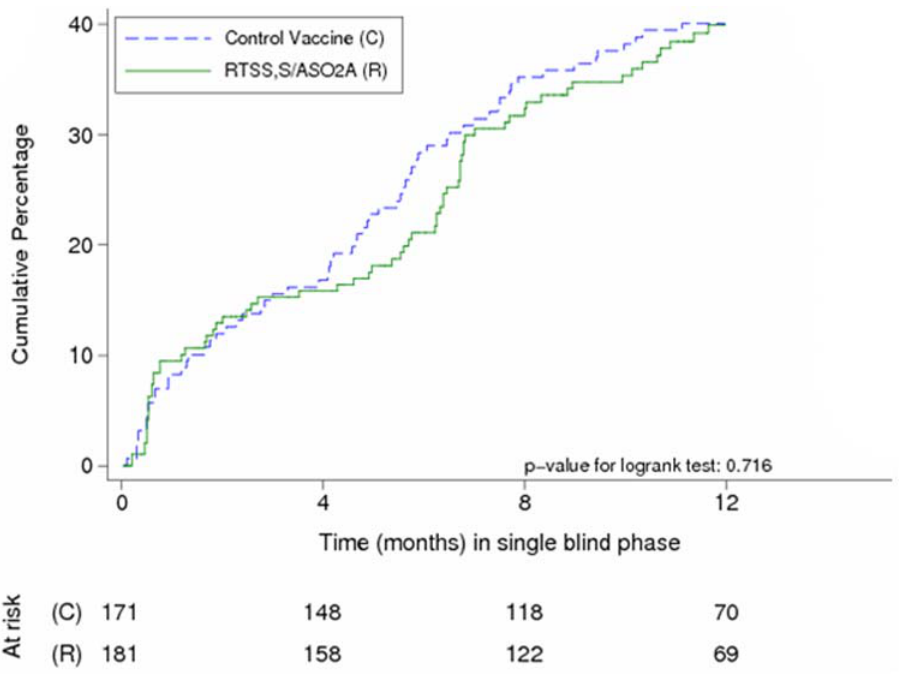
Figure 2. Kaplan-Meier survival curves for the cumulative proportion with at least one episode of clinical malaria during the double-blind and single-blind phases in cohort 2 respectively (ATP cohort).